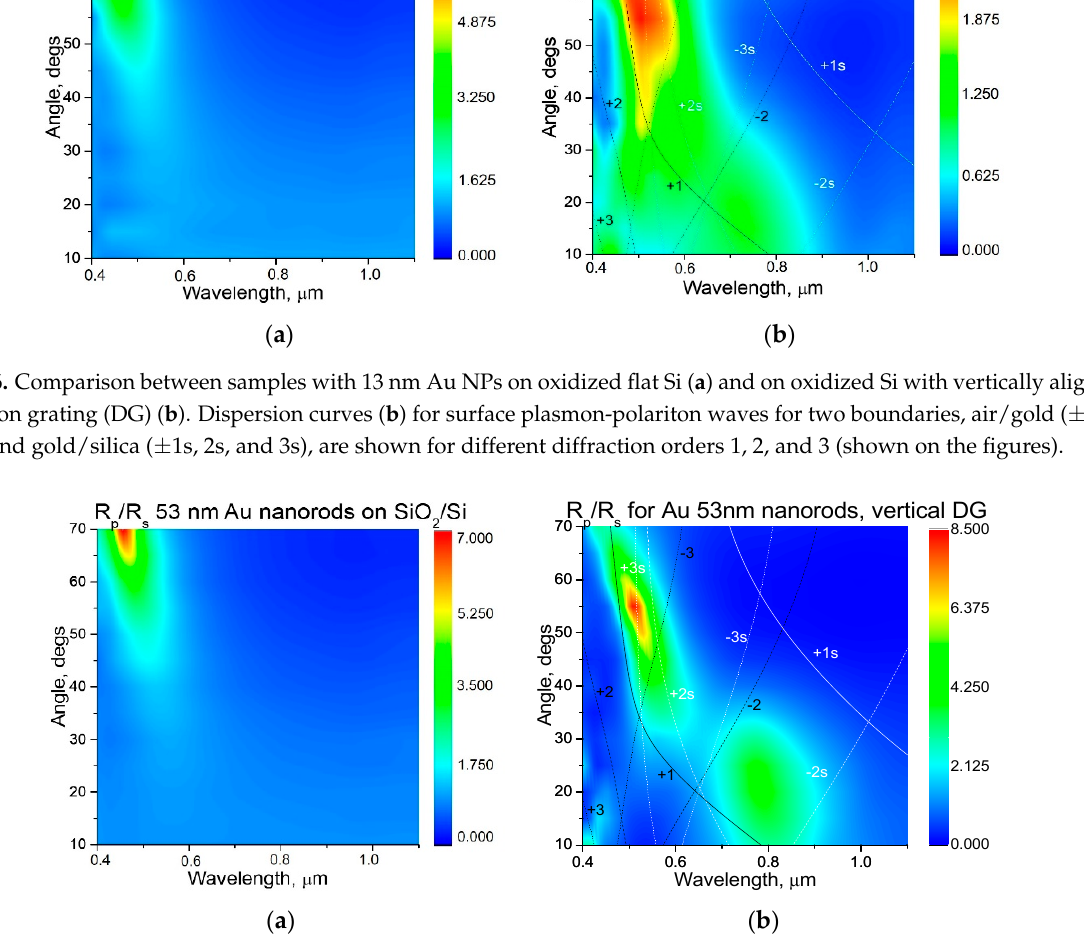
Figure 7. Comparison between samples with 53 nm Au nanorods on oxidized flat Si ( a ) and on oxidized Si with vertically aligned DG ( b ). Dispersion curves ( b ) for surface-plasmon-polariton waves for two boundaries, air/gold (±1, 2, and 3) and gold/silica (±1s, 2s, and 3s), are shown for different diffraction orders 1, 2, and 3 (shown on the figures).